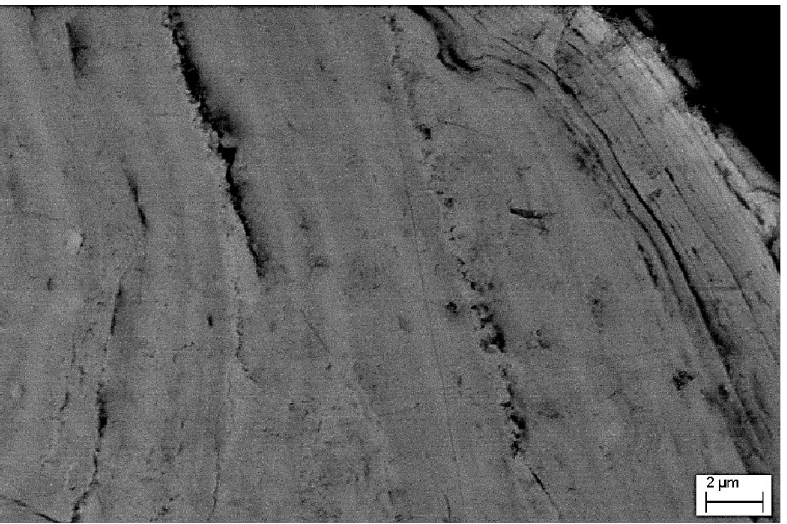
Figure 6. BSE image of a thin section of a sample from Stefføya displaying the laminar structure . XRD analyses were performed on crust samples collected from Stefføya and Valen.